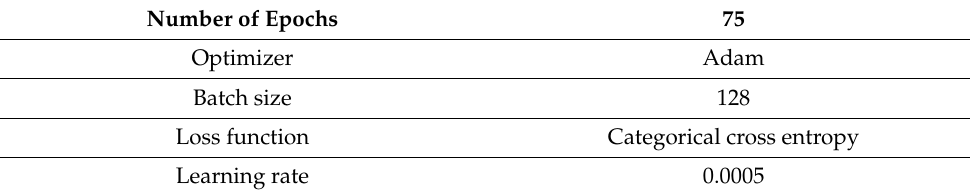
Table 3. The Parameters.